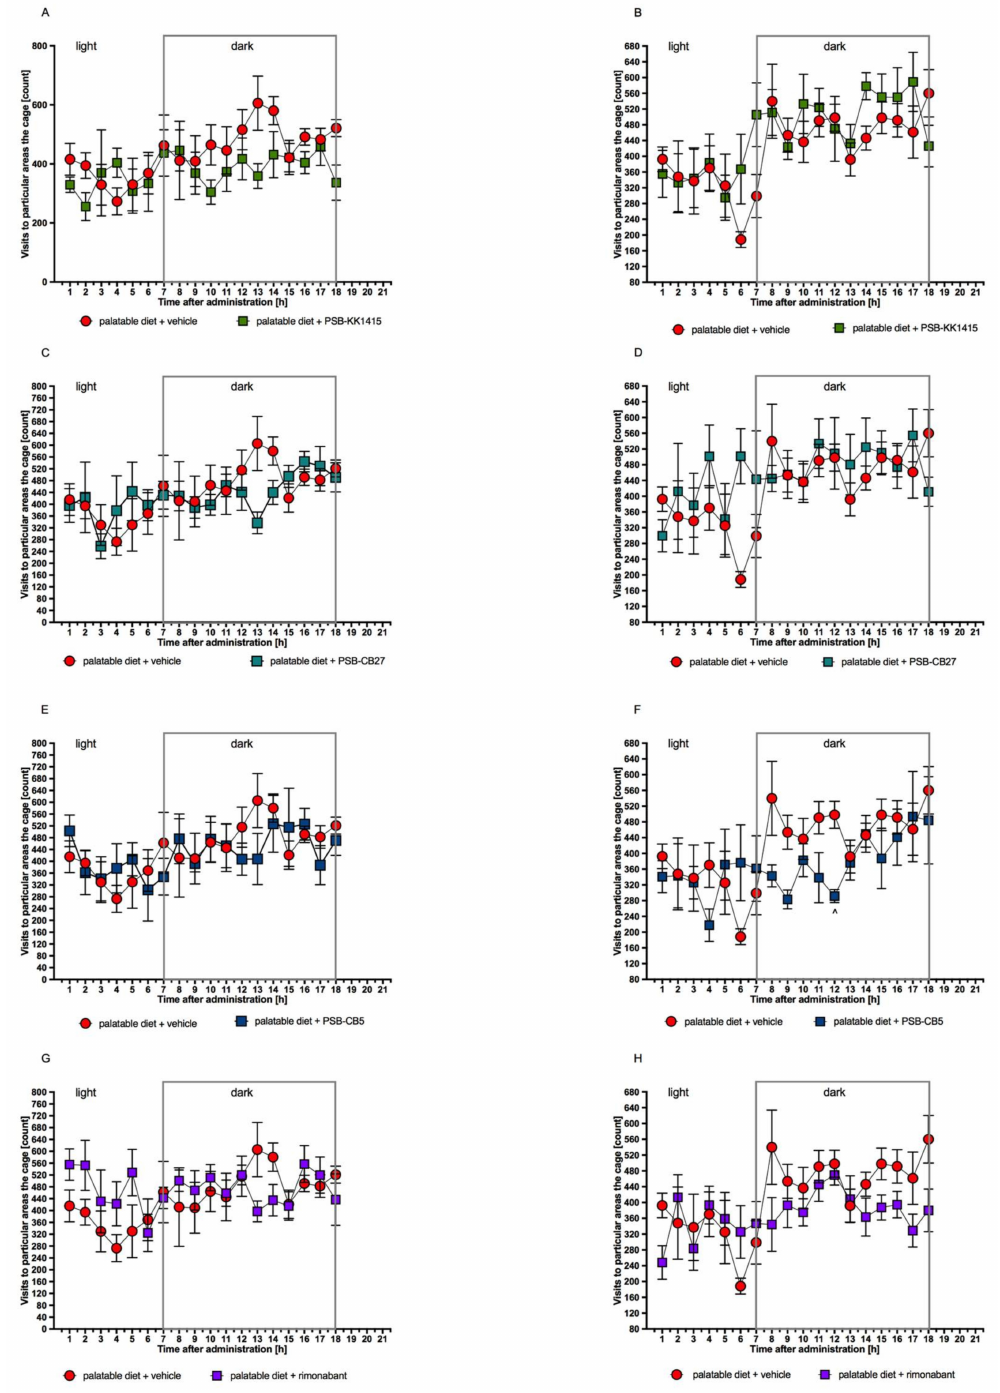
Figure 5. Influence of the GPR18 ligands or rimonabant on locomotor activity after a single dose ( A , C , E , G ) and chronic treatment ( B , D , F , H ). Locomotor activity of rats fed palatable feed during 18 h period after treatment with tested compounds (5 mg/kg b.w., i.p.), rimonabant (1 mg/kg b.w.), or vehicle. Activity is directly related to entrance to various areas of the cage. Results are the means ± SEM, n = 6 (multiple t -test). Significant differences are denoted by ˆ p <